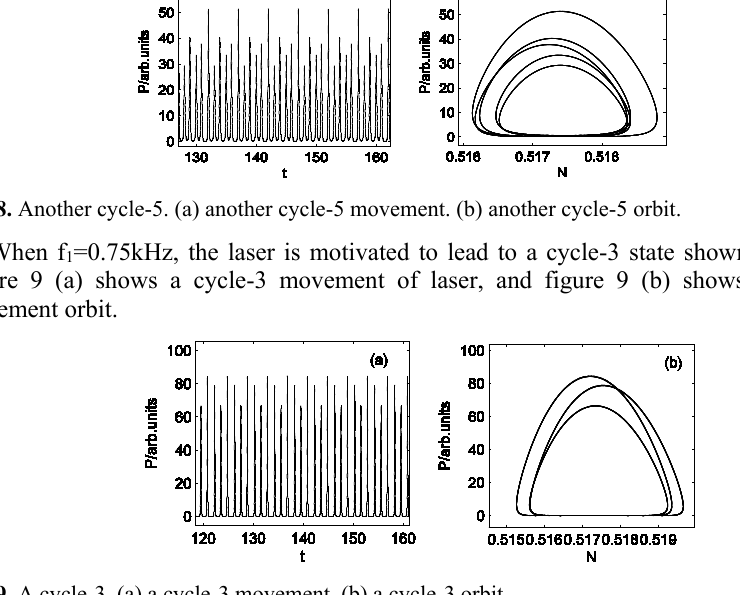
Fig. 9. A cycle-3. (a) a cycle-3 movement. (b) a cycle-3 orbit.